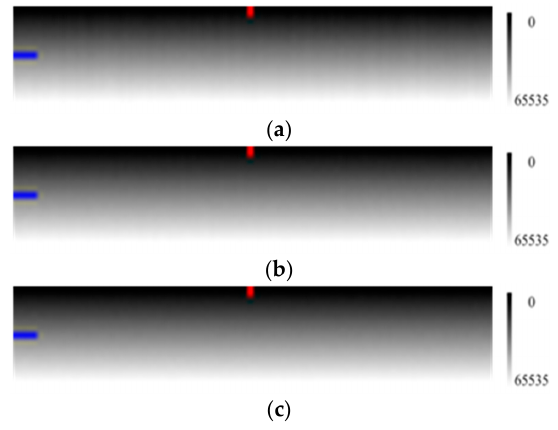
Figure 11. The relative calibration results of the verification image with gain and offset coefficients from a different number of radiance level, where the horizontal direction is the pixels and the vertical direction is radiance level. ( a ) the result with the coefficient from Figure 9a (3 radiance level data); ( b ) the result with coefficient from Figure 9b (20 radiance level data); and ( c ) the result with coefficient from Figure 9c (100 radiance level data). Column 50 and line 10 are marked with red and blue labels, respectively.